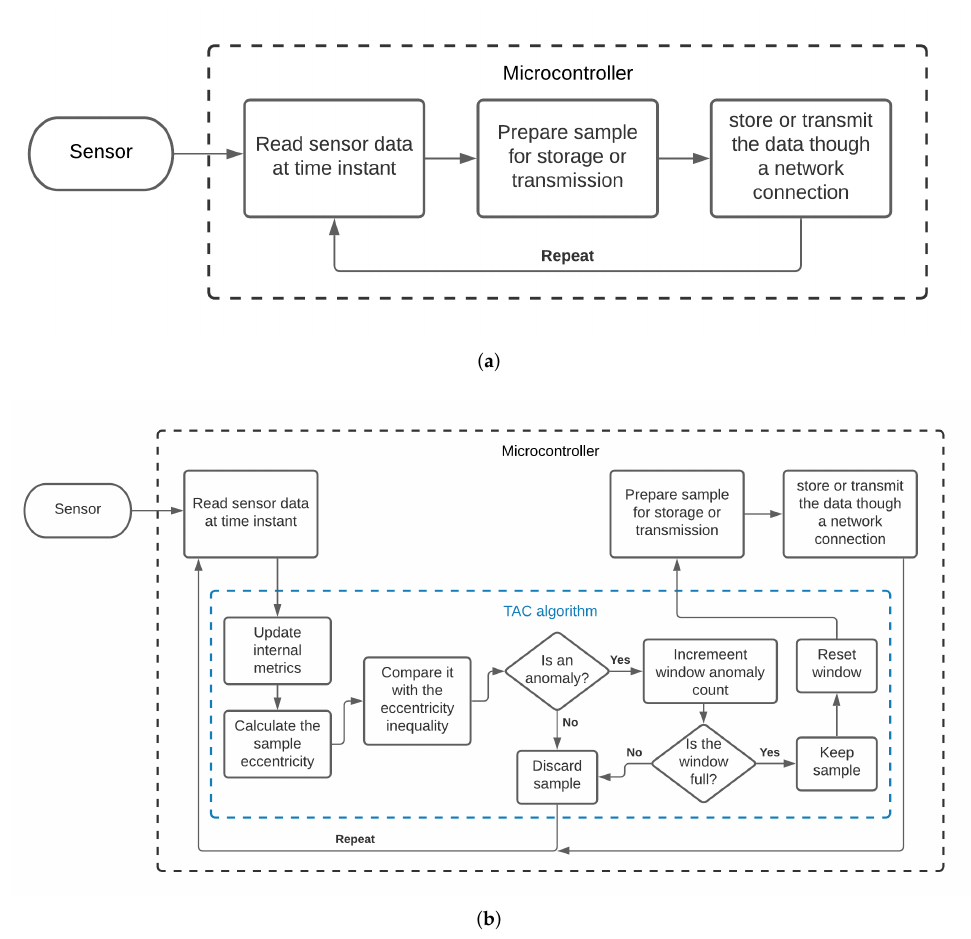
Figure 2. Execution flow. ( a ) Data flow without the TAC model; ( b ) Data flow with the TAC